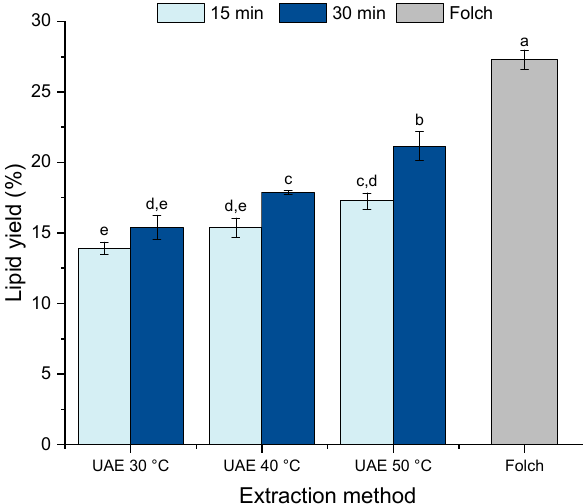
Figure 1. Effect of ultrasound-assisted extraction (UAE) process parameters (time and temperature) on lipid recovery. Results are expressed as a percentage of dry weight. Error bars denote the standard deviation of three independent extractions (n = 3). Different letters indicate statistically significant differences at p < 0.05 (one-way ANOVA with post-hoc Tukey, a–e).